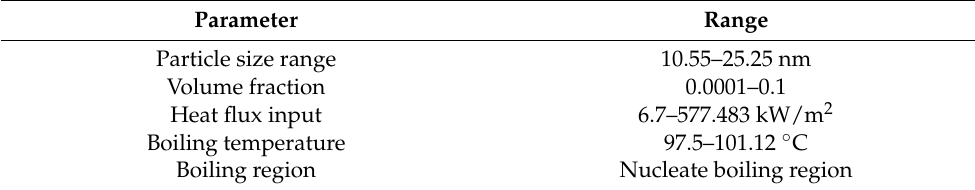
Table 1. Experimental conditions applied to the present